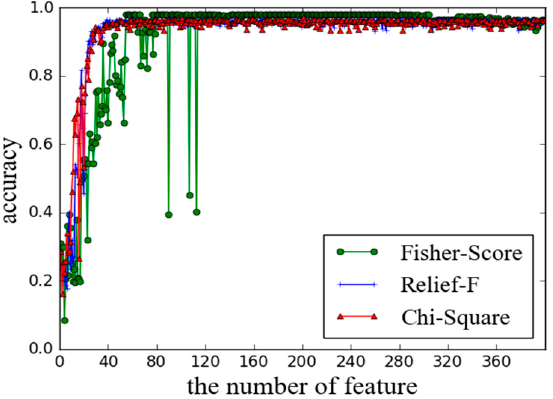
Figure 7. Three feature selection algorithm results in multiple classification.